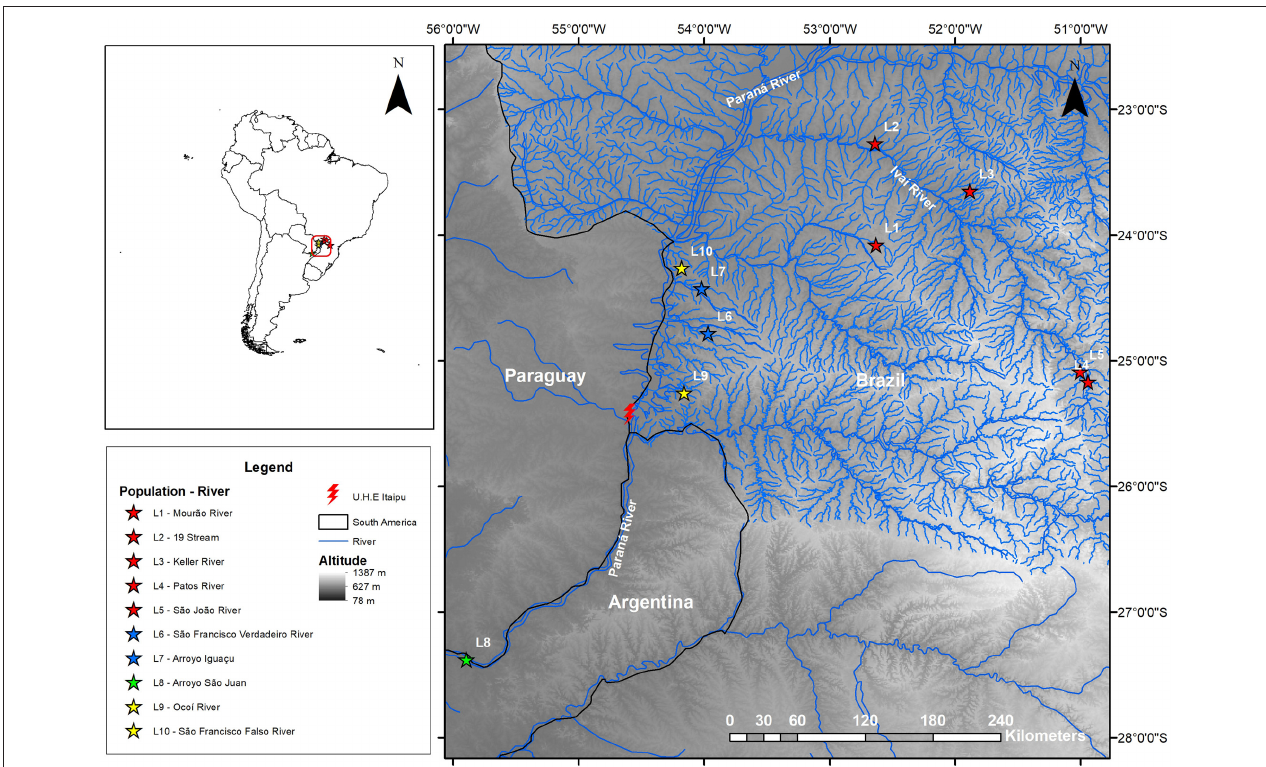
FIGURE 1 | Topographic map showing the sites for the collection of specimens from the Ancistrus populations sampled in the Paraná River basin, in the present study. Each color represents a different clade recovered in our phylogenetic inferences (see Figure 2 ): red star, populations in clade I; blue star, populations in clade II; green star, populations in clade IV; and yellow star, populations in clade V. L1, Mourão River; L2, 19 Stream; L3, Keller River; L4, Patos River; L5, São João River; L6, São Francisco Verdadeiro River; L7, Arroyo Iguaçu; L8, Ancistrus cirrhosus ; L9, Ocoí River; L10, São Francisco Falso